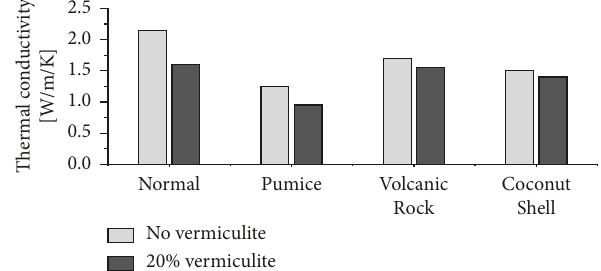
Figure 8: Thermal conductivity of concrete specimens with and without 20% vermiculite content.